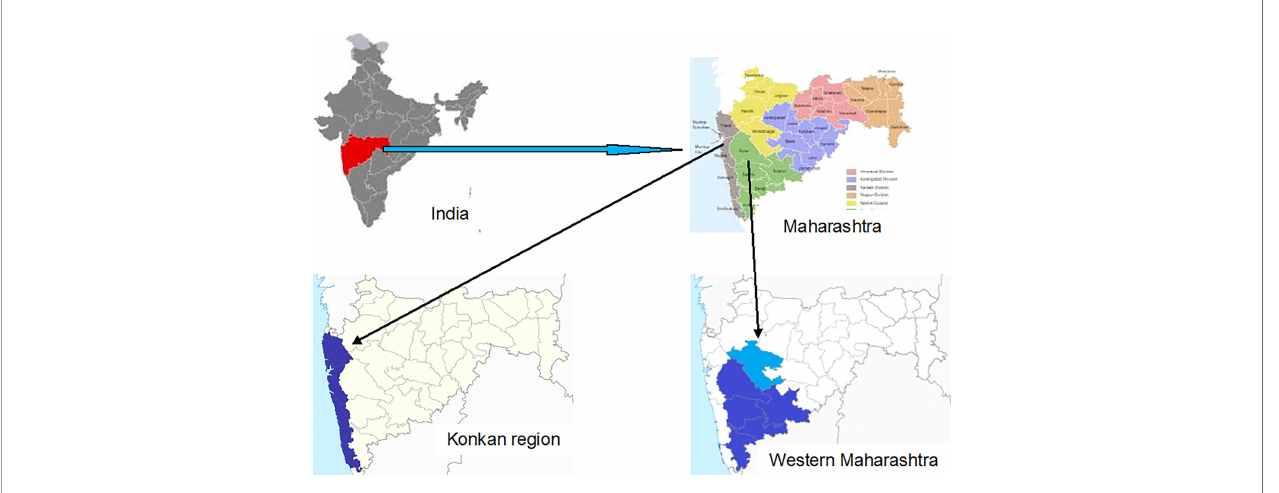
FIGURE 1 | Map showing the location of the study